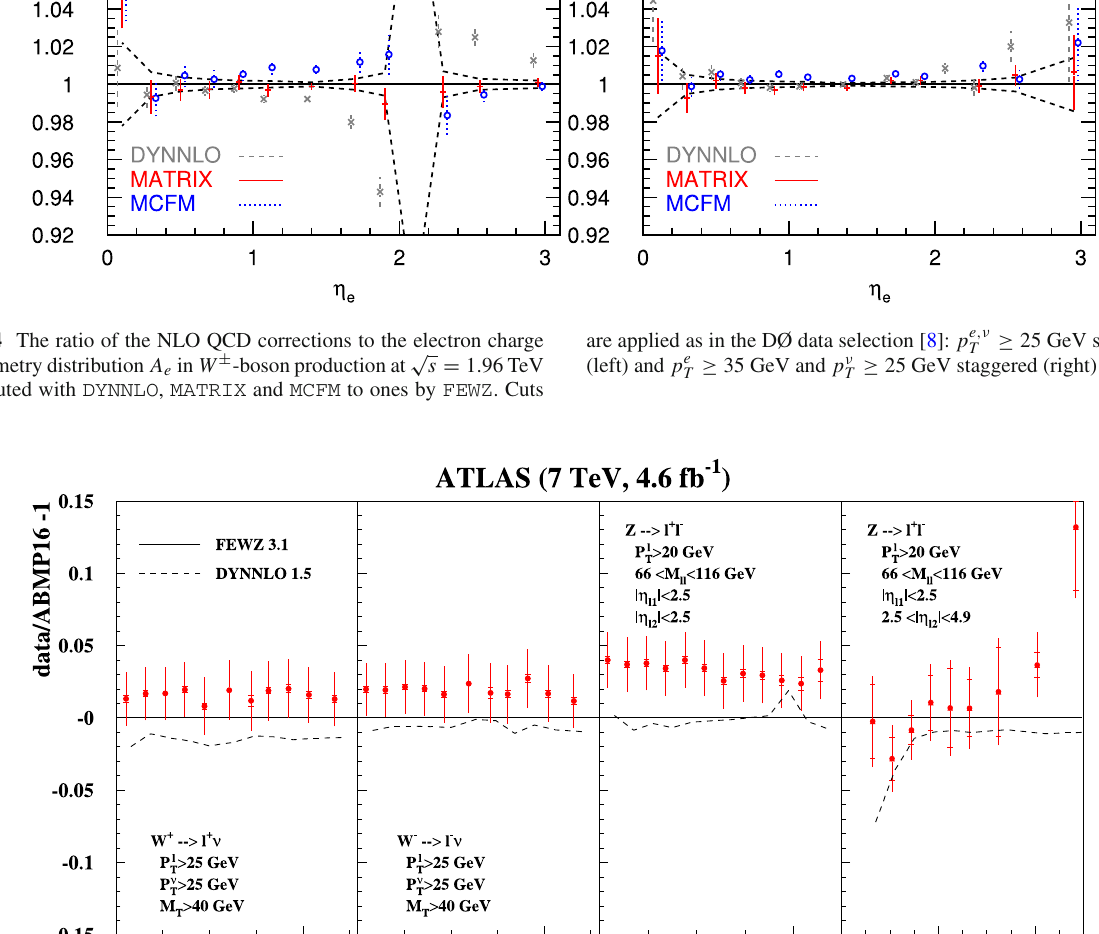
leptonsinthefinalstateareindicatedinthefigure.TheABMP16central predictions at NNLO are obtained with FEWZ and the deviations of the predictions from DYNNLO are shown (dashed) for